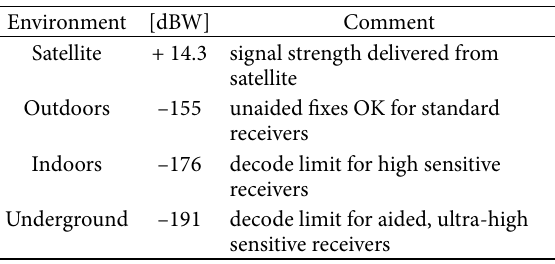
table 2. Signal strength in decibel watt (decibels relative to one watt) of GNSS satellites